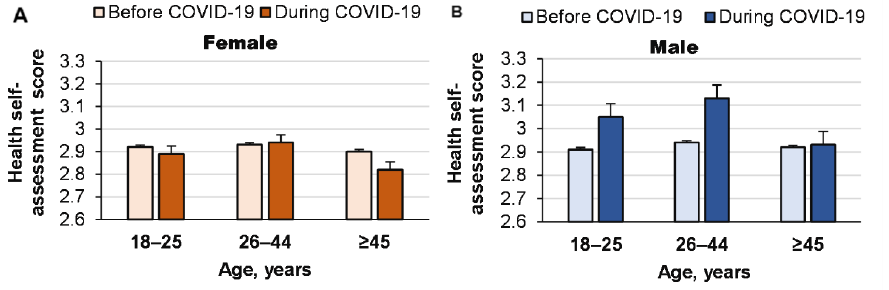
Figure 1. Influence of COVID-19 on health self-assessments of men and women of different ages. The pandemic had no significant effect on women’s health self-assessment ( χ 2 = 5.2; p = 0.157; Table 1). Table 1. Influence of the pandemic on the health self-assessments of women and